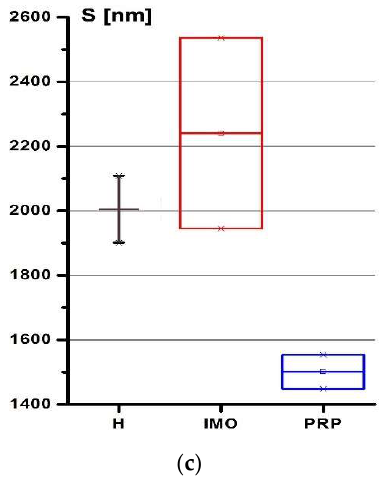
Figure 2. The roughness parameters in group 1 (H), group 2 (IMO—induced model of osteoarthritis), and group 3 (PRP): ( a ) the arithmetic average of absolute values (Ra); ( b ) the maximum peak height (Rp); ( c ) the mean spacing between local peaks (S).